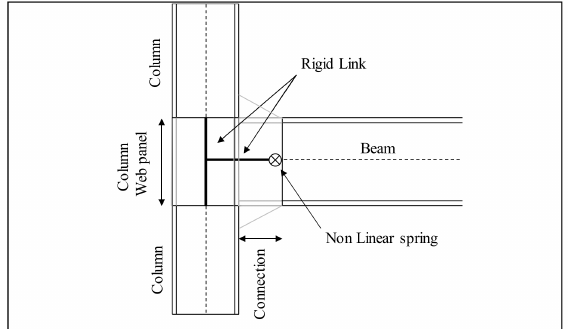
Figure 2. Beam-to-column joints modelling features introduced in the structures.